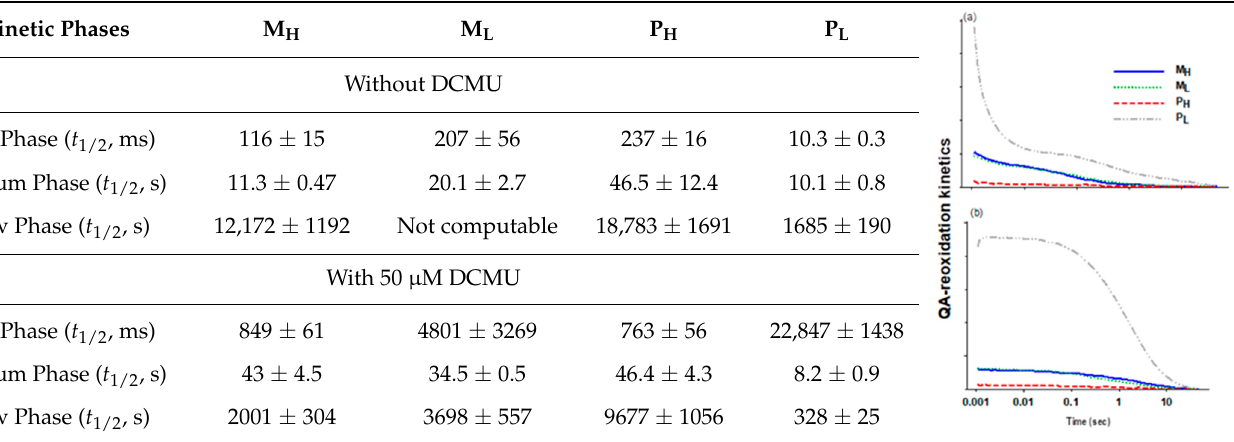
Table 2. Q A − re-oxidation kinetics of A. protothecoides cultivated under white light. Inset figures: Q A − re-oxidation kinetics without ( a ) and with 50 μ M 3-(3,4-dichlorophenyl)-1,1-dimethylurea (DCMU) ( b ). Data represent the average ± SD of three replicates (n = 3). (M H and M L stands for mixotrophy with high and low peptone, respectively, and P H and P L stands for photoautotrophy with high and low peptone, respectively).